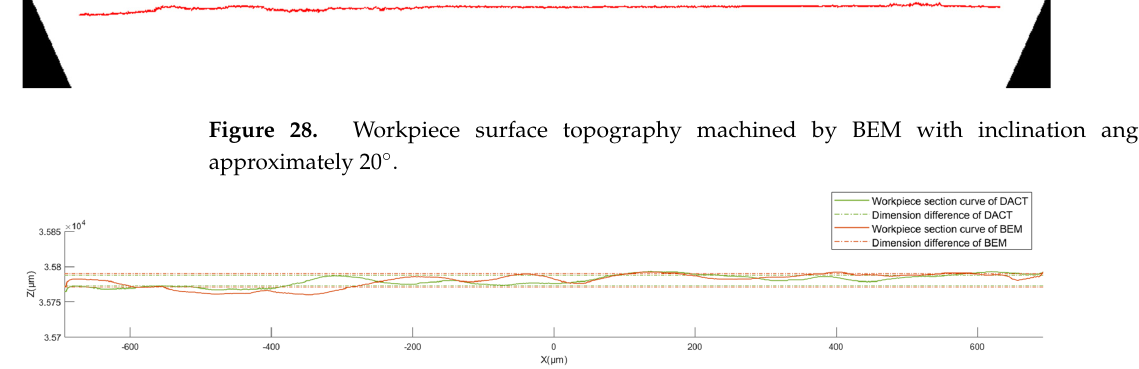
Figure 29. Standard deviation interval of concave and convex ruled surface.